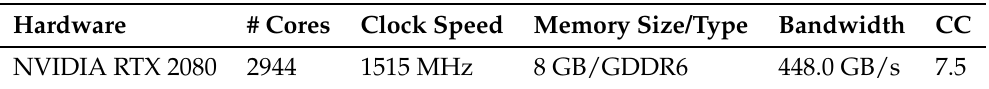
Table 1. Overview of the GPU hardware used in the experiments. The column labeled “CC” indicates the compute capability version of the